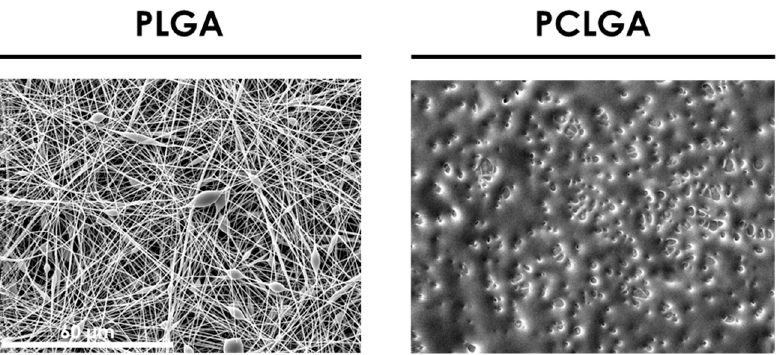
Figure 1. SEM images of Poly(lactic-co-glycolic acid) (PLGA) and poly(caprolactone-co-glycolic acid) (PCLGA) electrospun membranes at 10% w/v in 1,1,1,3,3,3-hexafluoro-2-propanol (HFIP), 2 mL/h, 17 kV and 13 cm. Both images share the scale bar: 60 μ m.